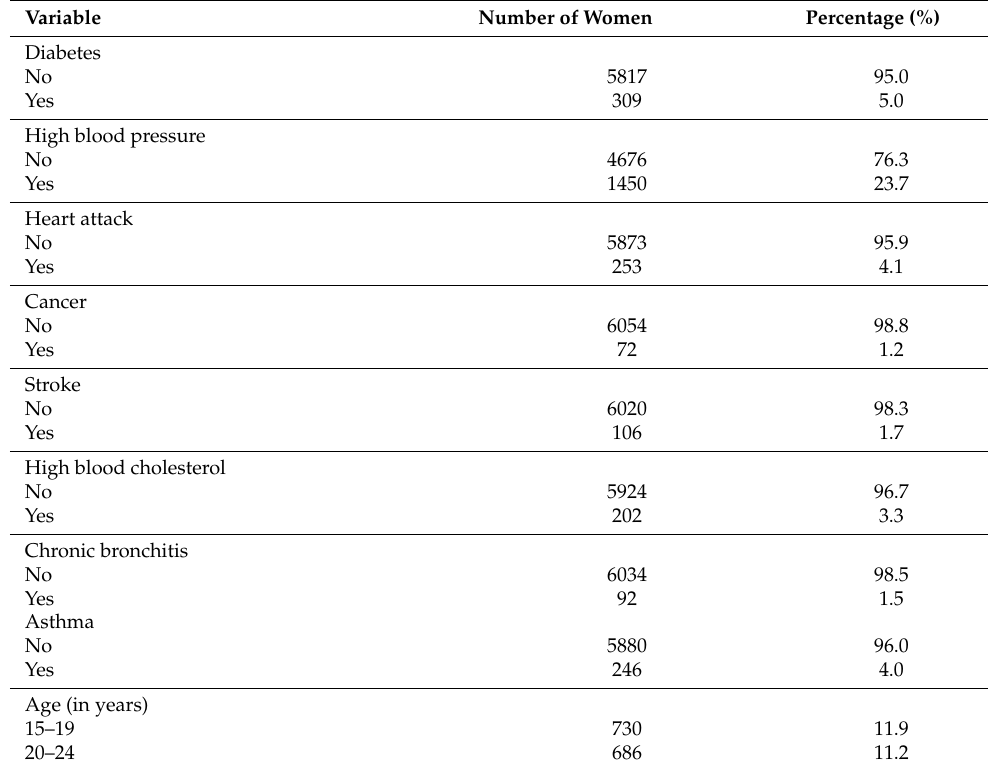
Table 1. Distribution of women’s